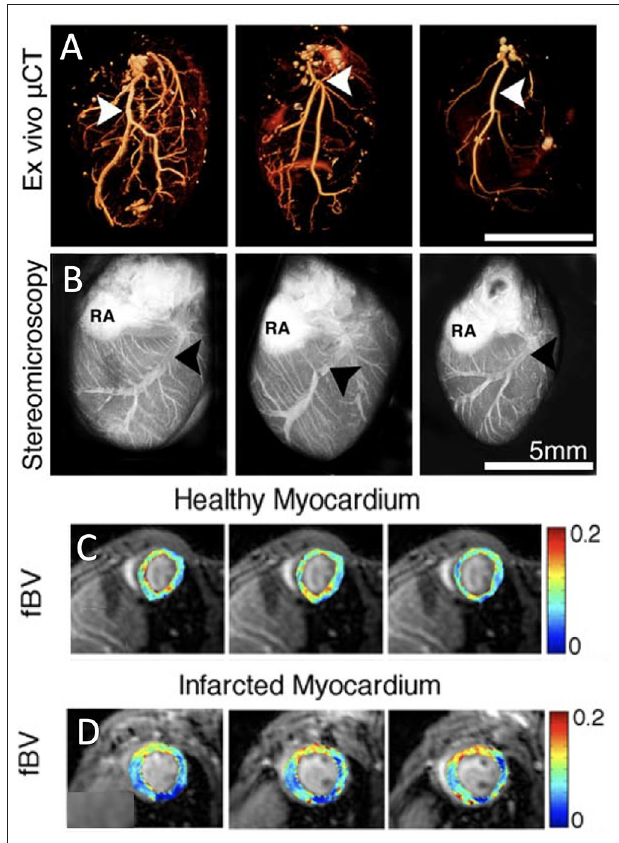
FIGURE 2 | Vessel density and perfusion imaging. (A) Volume-rendered ex vivo micro-computed tomography ( µ CT) images of cardiac macrovasculature filled with radio-opaque silicone rubber highlight the left coronary artery (white arrowheads). (B) Stereomicroscopic ex vivo images of cardiac vasculature after intravenous injection of red-fluorescence-labeled albumin [LCV, left coronary vein (black arrowheads); RA, right atrium; adopted from (21)]. (C) Parametric three-dimensional pixel-based maps of fractional blood volume as a measure of microvascular density in healthy myocardium using dynamic contrast enhanced (DCE)-MRI. (D) Similarly, DCE-MRI parametric maps of infarcted myocardium [adopted from (